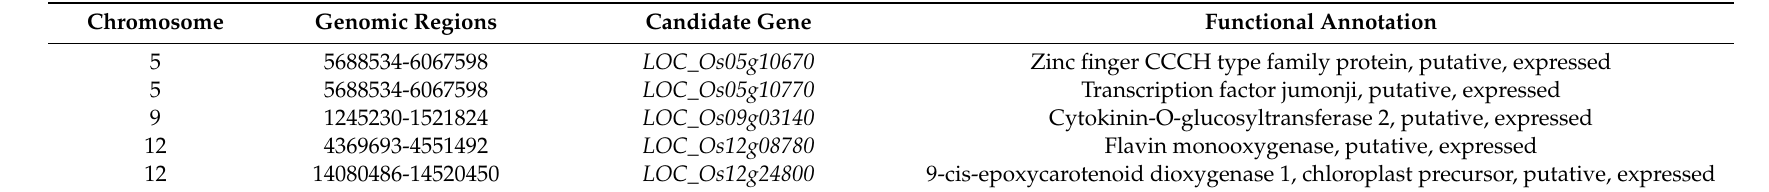
Table 3. High confidence candidate genes for mesocotyl lengths in 208 rice landraces or